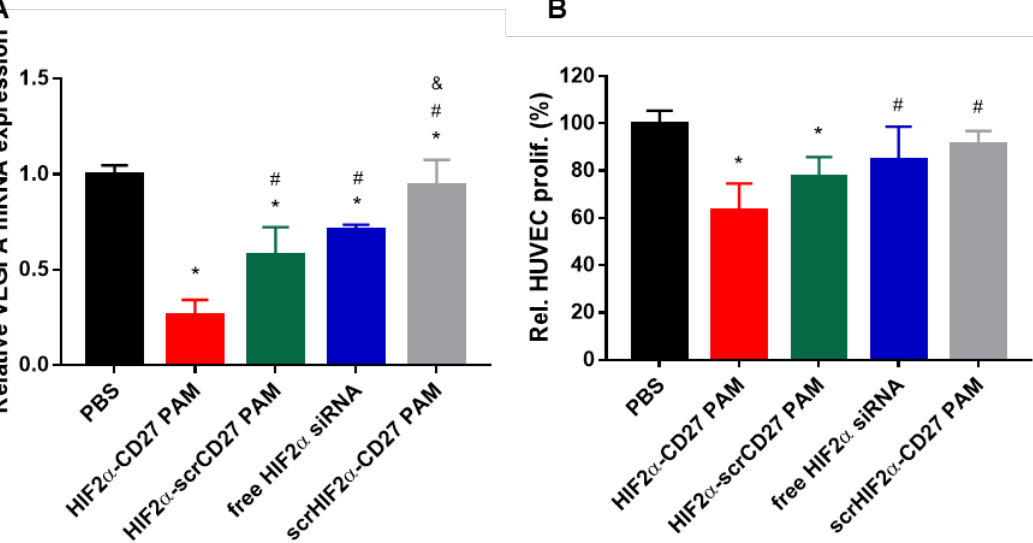
Figure 6. 48 h HIF2α -CD27 PAM treatment (500 nM siRNA) reduces ( A ) VEGFA mRNA expression in patient-derived ccRCC. ( B ) HUVECs cultured with HIF2α -CD27 PAM-conditioned culture medium have reduced proliferation relative to PBS-conditioned culture medium. N = 5. * p < 0.05 relative to PBS. # p < 0 .05 relative to HIF2α -CD27 PAMs. & p < 0 .05 relative to HIF2α -scrCD27 PAMs.